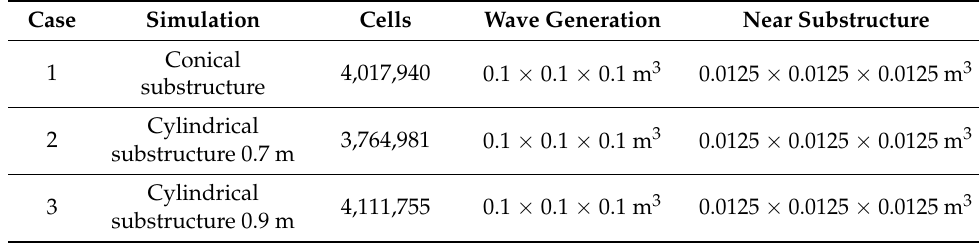
Table 7. Simulation discretization